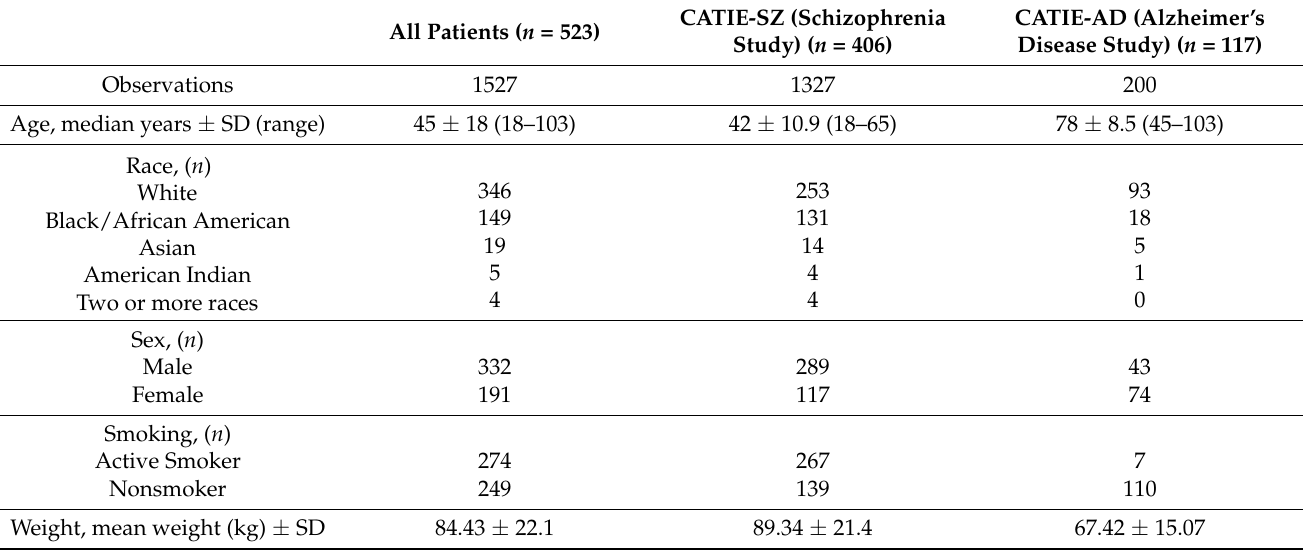
Table 1. Demographic information of each study and pooled